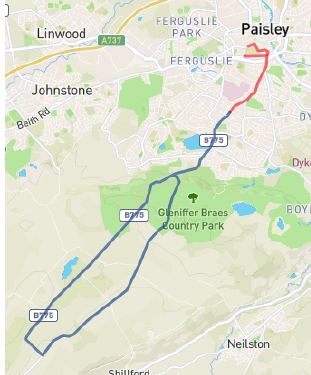
Figure 5. Chosen route for the experiments. The section of the route where both drivers took control of the vehicle is marked in red. The section of the route where it was only the remote driver who had control over the car is marked in blue.